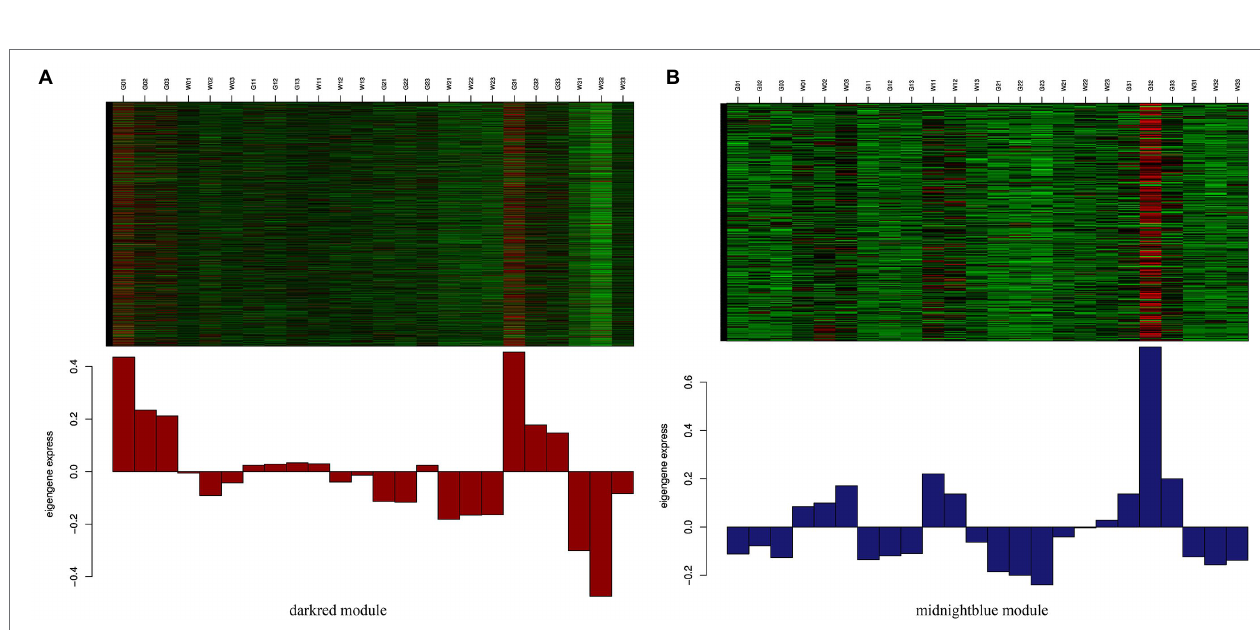
FIGURE 6 | Expression levels of genes from darkred module (A) and midnightblue module (B) . Those between the darkred and midnightblue modules are most significantly correlated with “Gannong NO.3” and “WL326GZ” following exposure to freezing